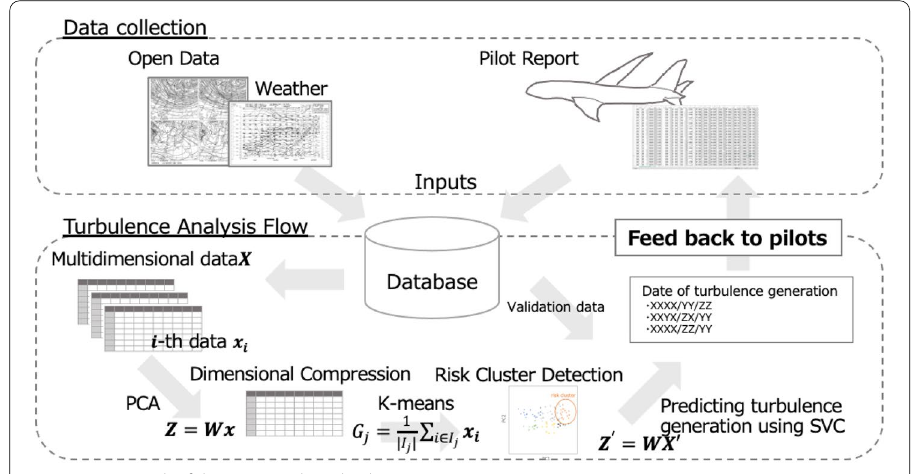
Fig. 1 Framework of the proposed